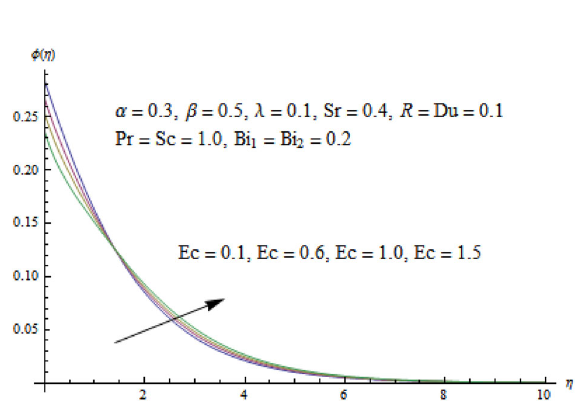
Fig. 24 Impact of Ec on